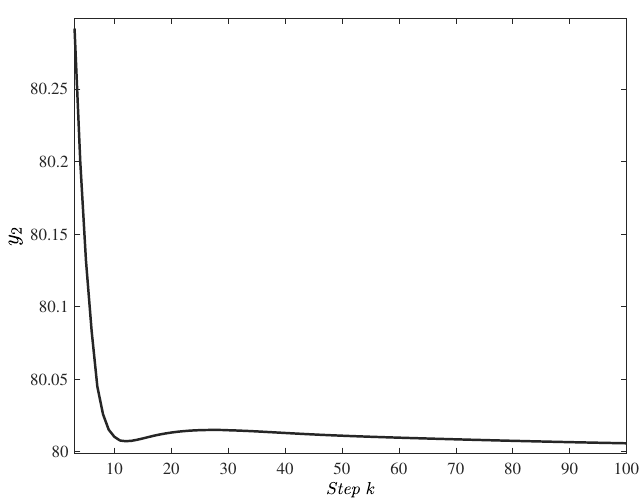
Figure 11. Electric power (MW).